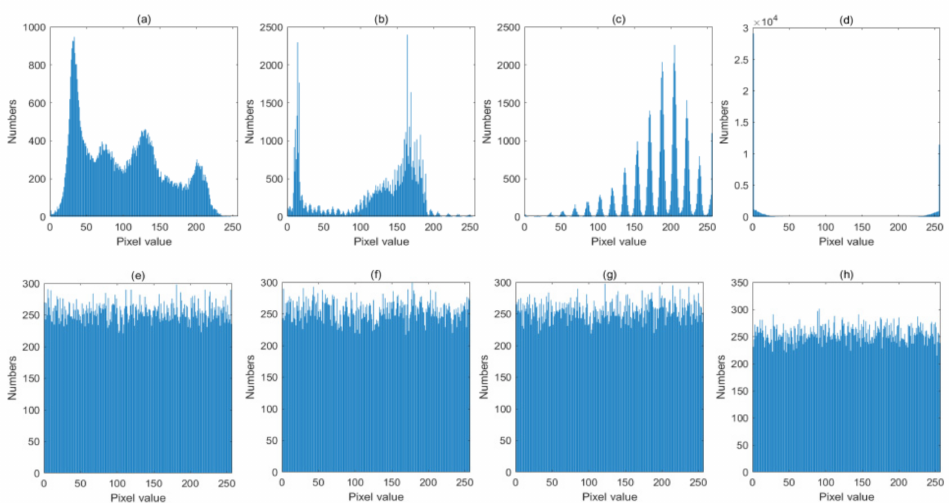
Figure 11. Histograms of images ( a – d ). Original images: Lena, Cameraman, Horse and Granules; ( e – h ) encrypted images: Lena, Cameraman, Horse and